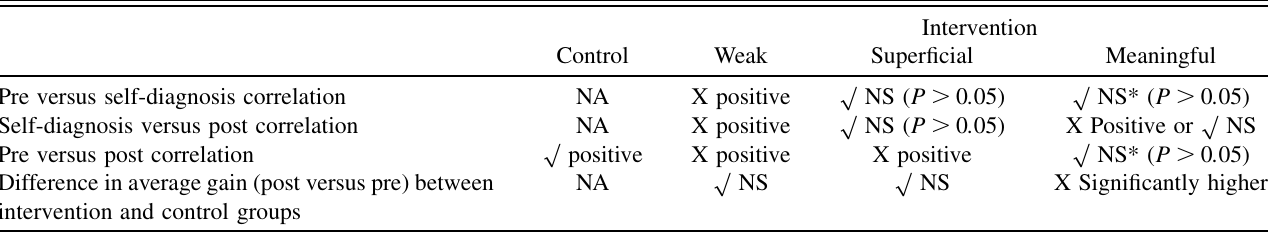
TABLE XII. Conflict between actual and expected correlations. (NA indictes an item being not applicable; NS, nonsignificant difference; NS*, nonsignificant difference due to low achievers reducing the gap between themselves and high achievers.) The checkmark stands for expected correlations that were confirmed by the analysis, and the X stands for expected correlations that were not confirmed by the analysis.